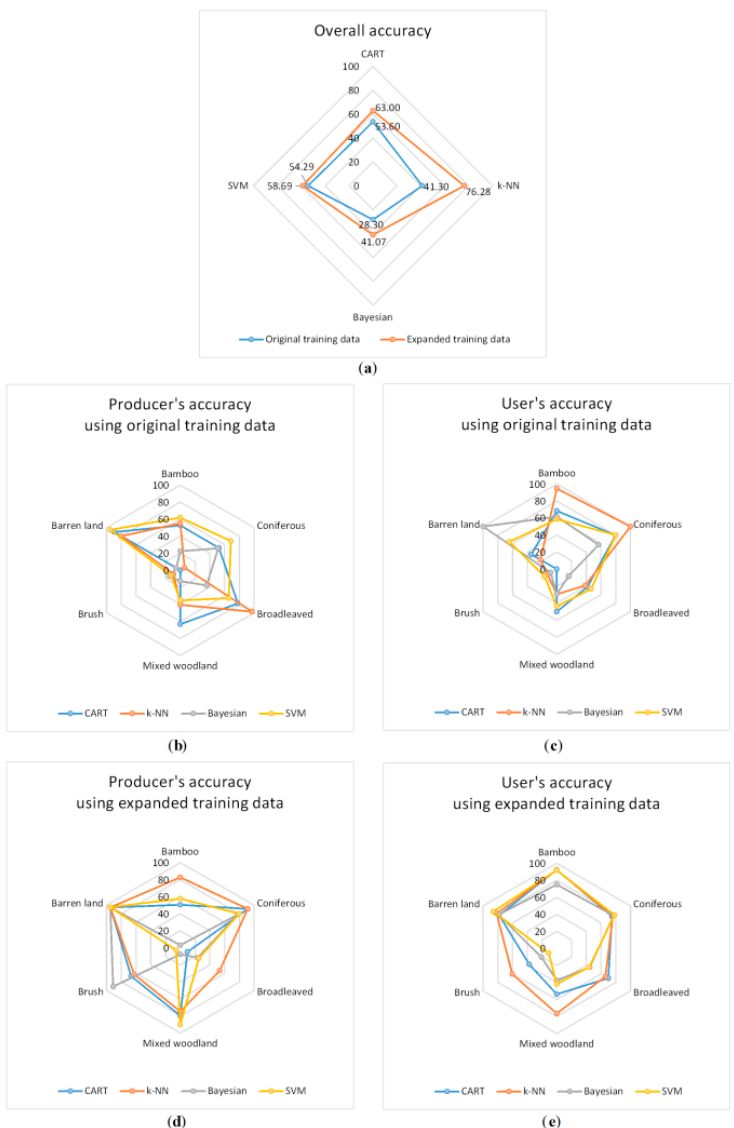
Figure 10. Radar charts of the accuracies using different classification methods based on the original and expanded training data (unit: %). ( a ) Overall accuracy; ( b ) Producer’s accuracy using original training data; ( c ) User’s accuracy using original training data; ( d ) Producer’s accuracy using expanded training data; ( e ) User’s accuracy using expanded training